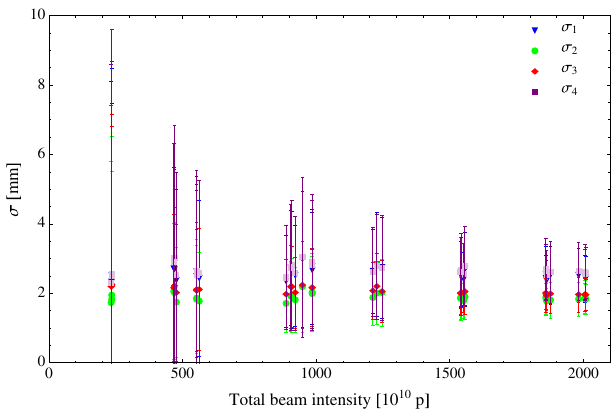
FIG. 11. Beamlets’ sigma (cid:6) i , from the fit using Eq. (6) of the data shown in Fig. 7, vs total beam intensity. Also in this case the error bars are determined from the fitting procedure and feature a clear degradation towards low intensities. Nevertheless, no rele- vant difference of beam size for the four beamlets is